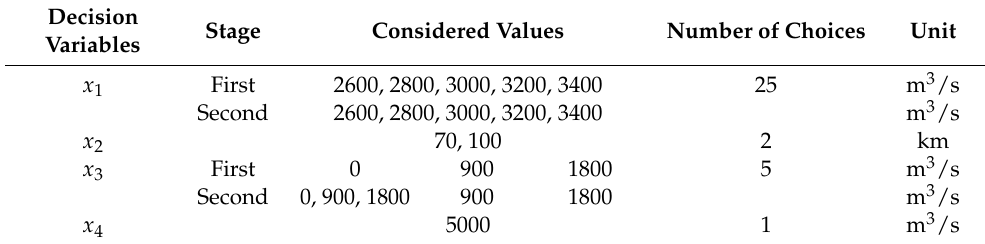
Table 3. Summary of 250 alternatives in adaptive decision